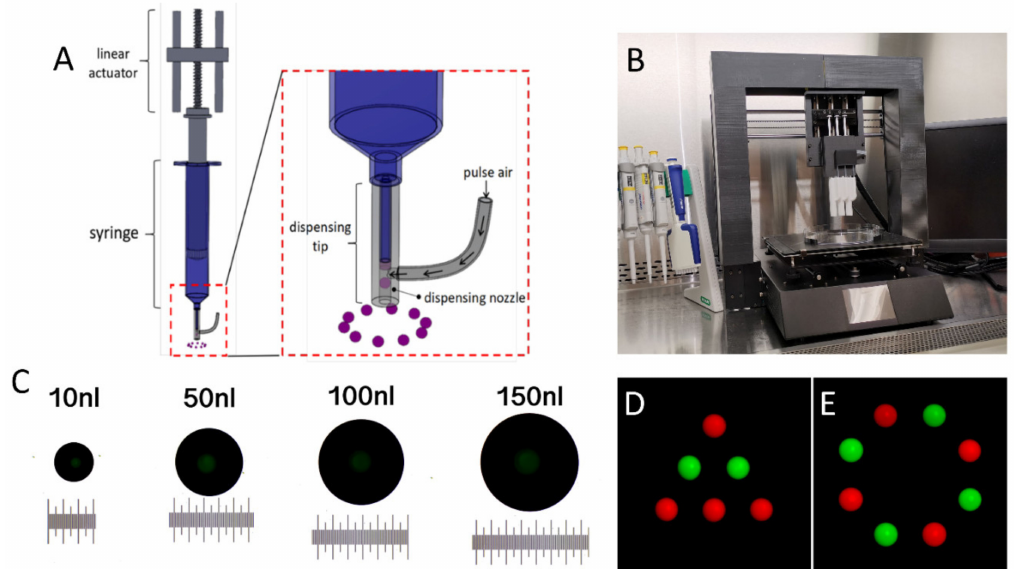
Figure 1. ( A ) Illustration of the dispensing mechanism of the DVDOD 3D bioprinting technology. ( B ) A representative set-up of a DVDOD 3D bioprinter. ( C ) Representative images of food dye solution dispensed into mineral oil at specific input volumes. The minimal scale equals 10 µ m. ( D , E ) Representative patterned droplets dispensed onto the surface of a Petri dish. Green and red droplets were dispensed from two discrete dispensing